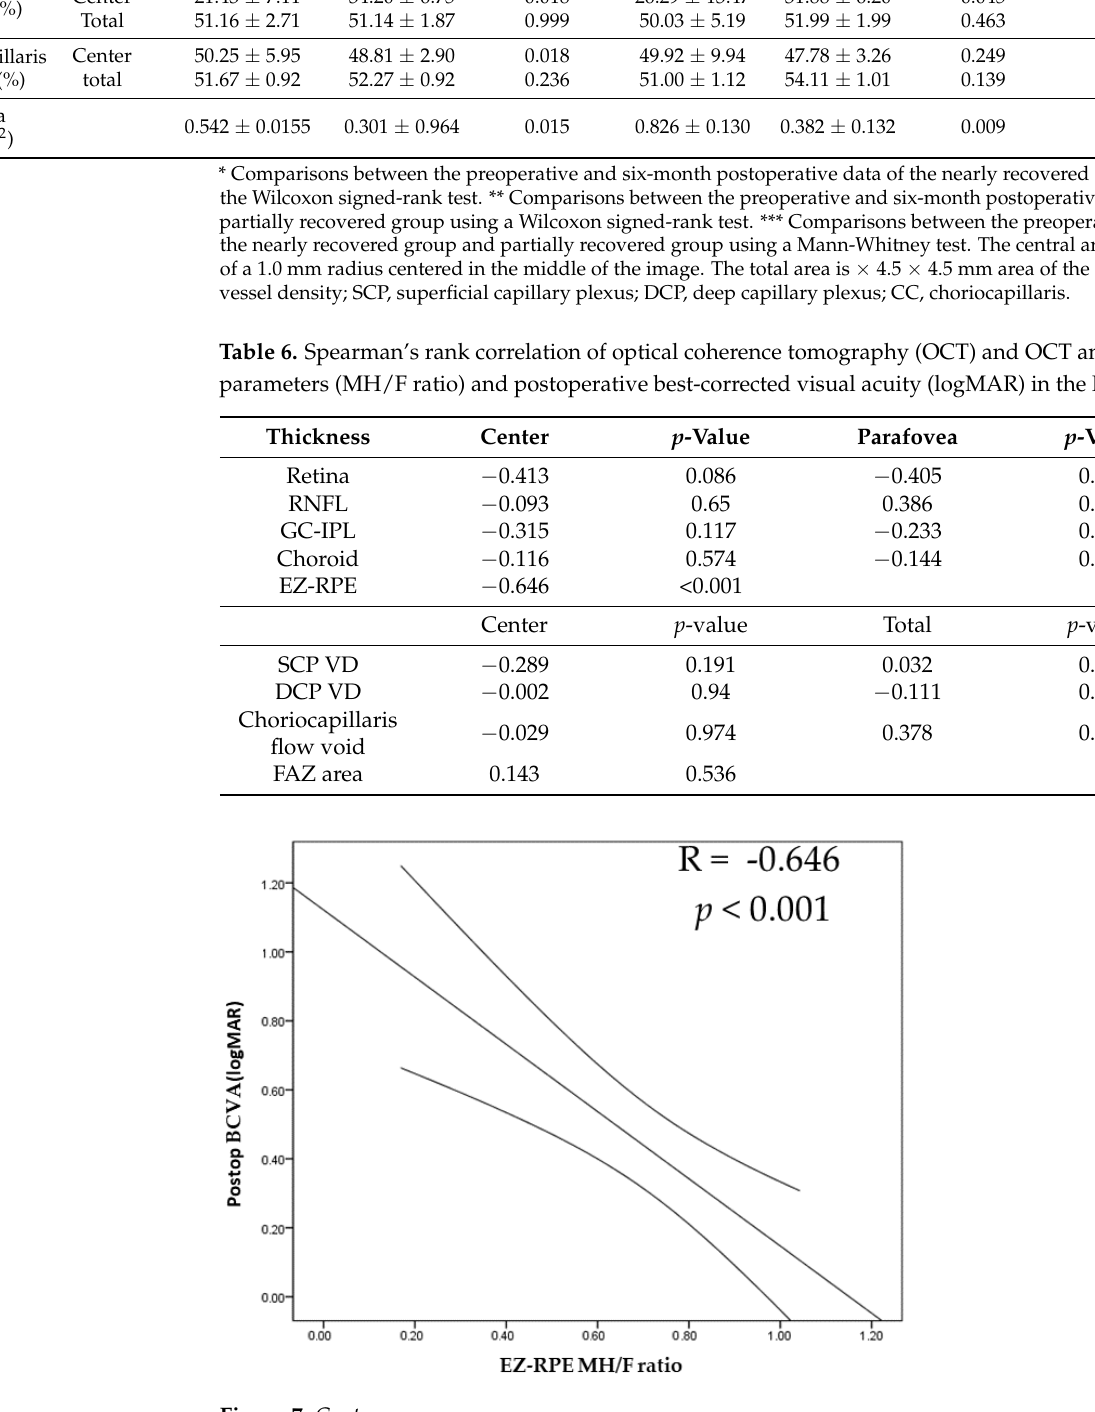
Figure 7. Correlation of postoperative BCVA with the EZ-RPE MH/F and total CC flow void MH/F ratios. The curved lines indicate a 95% confidence interval of the linear regression line. EZ-RPE MH/F ratio, ellipsoid zone to retinal pigment epithelium distance in the MH/unaffected eye; total CC flow void MH/F ratio, total choriocapillaris flow void of the MH/unaffected eye. 4. Discussion This study investigated structural and vascular changes in idiopathic FTMH pre- and postoperatively using SS-OCT and SS-OCTA. We compared chorioretinal structure and microvasculature by dividing the eyes into two groups based on the degree of outer reti- nal recovery, which is an important prognostic factor for visual recovery after MH sur- gery. We found that the choriocapillaris flow void appeared to be related to the degree of recovery of the outer retinal layer. Furthermore, our study indicated that EZ-RPE thick- ness and small choriocapillaris flow voids were associated with better visual acuity after MH surgery. Many studies have reported inner retinal thinning on OCT after MH surgery, in which the ILM peeling technique leads to higher anatomical closure and lower recurrence rates [3] . However, the thickness of the inner retinal layer adjacent to the ILM could be